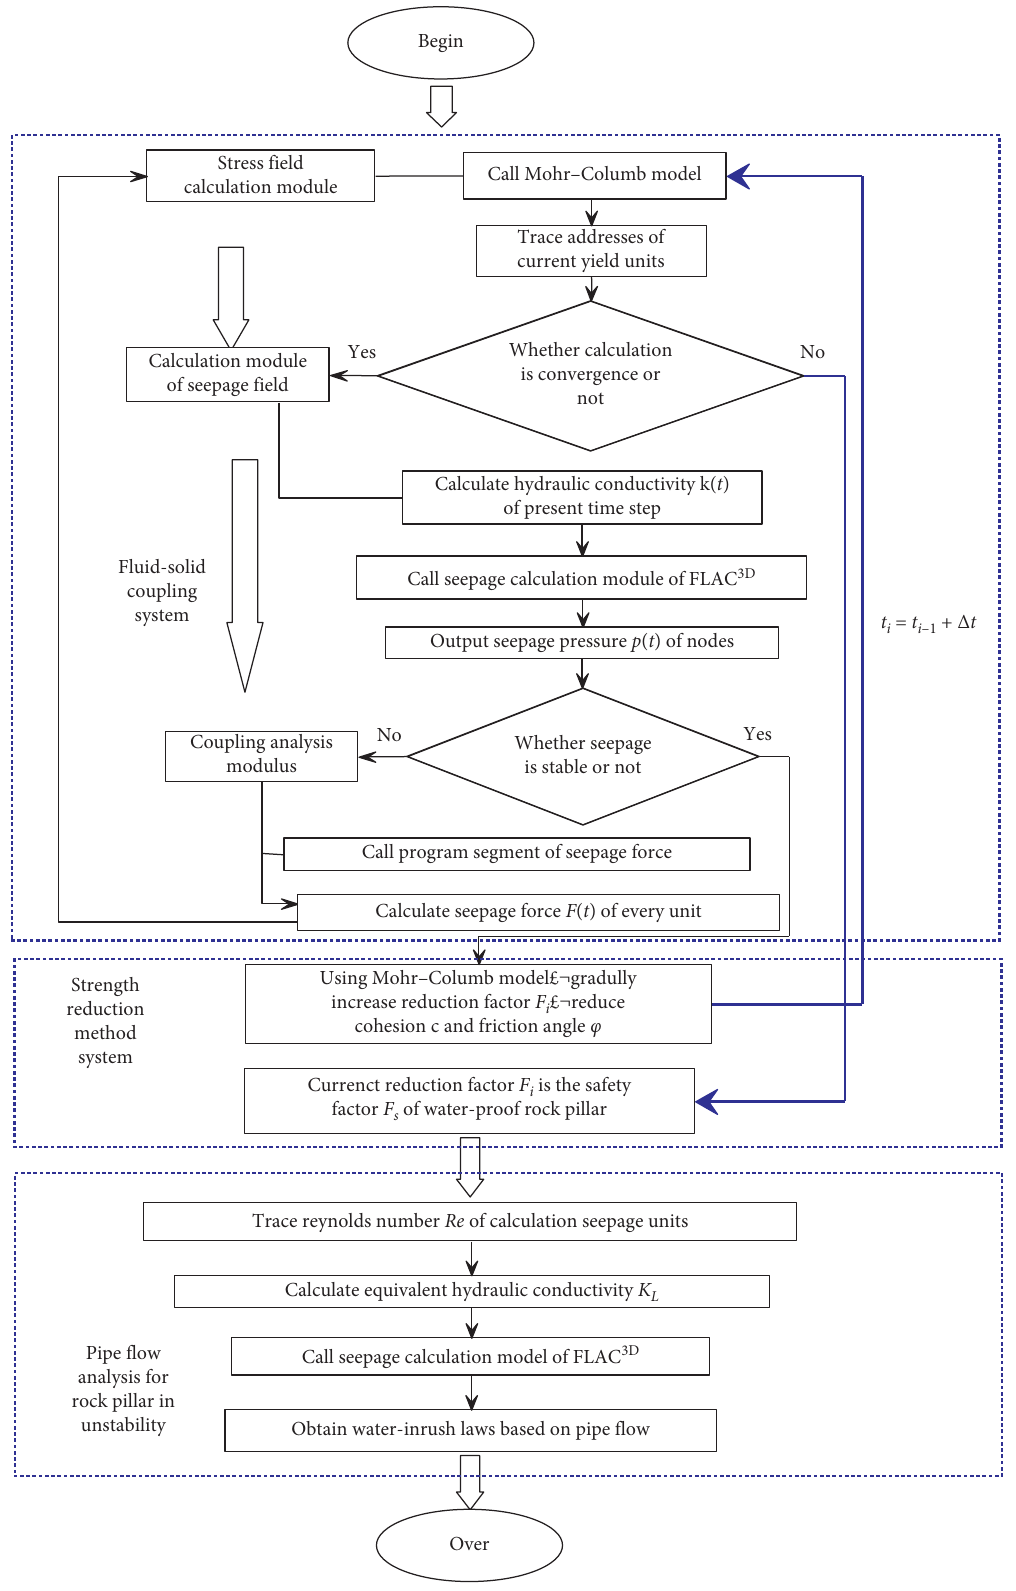
Figure 4: Flow diagram of linkage analysis between solid-fluid coupling and the strength reduction method based on flow state conversion